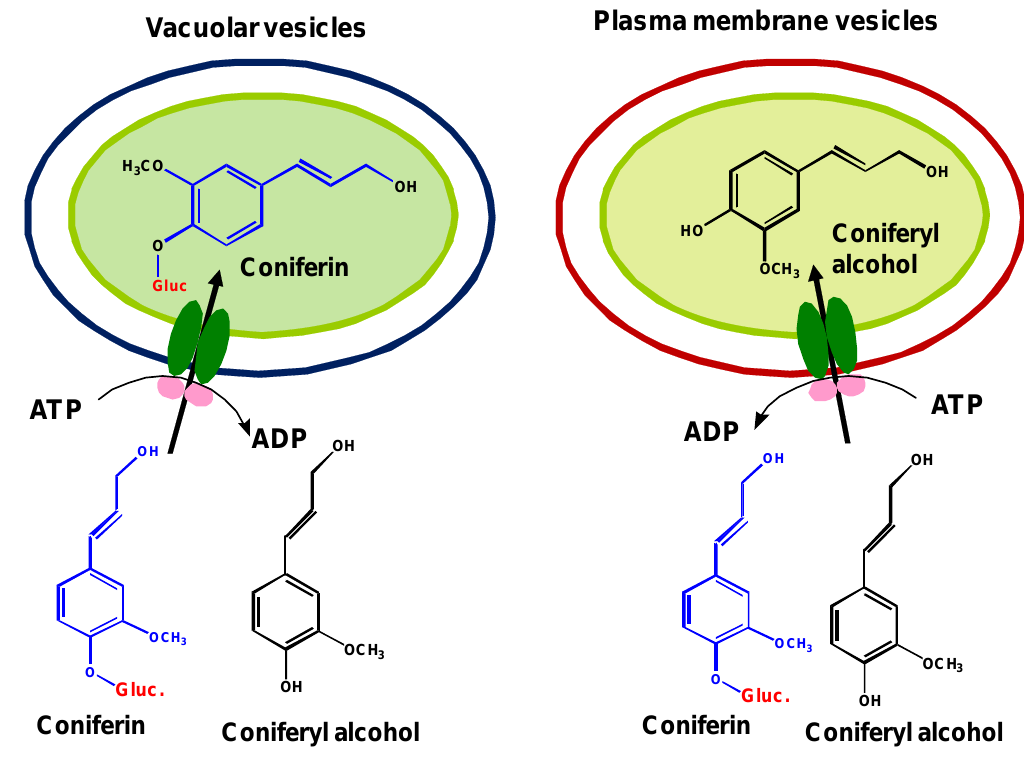
Figure 2. ATP-dependent, selective uptake of monolignols or their glucosides by vacuolar vesicles and the inside-out plasma membrane